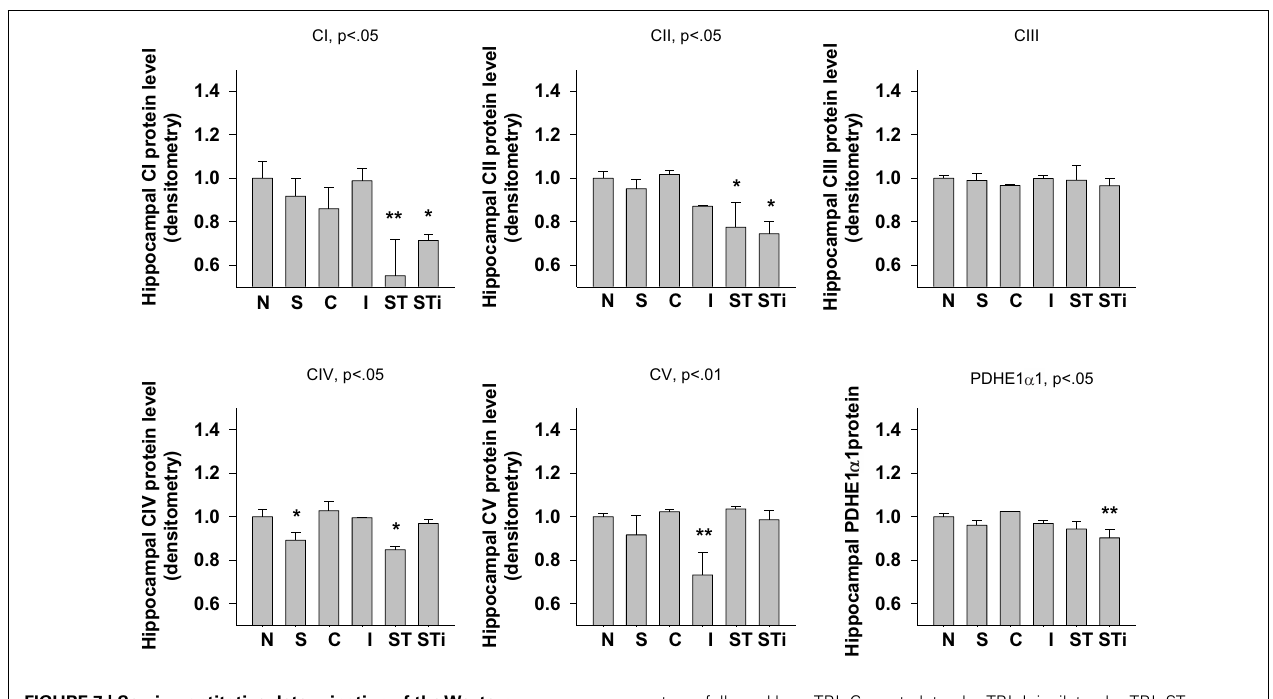
FIGURE 7 | Semi-quantitative determination of theWestern blotting protein bands density of ETC subunits CI, CII, CIII, CIV, CV proteins, and PDHE1 α 1 protein expressed in rat hippocampus 7days post mTBI . N, Naïves; S, 3days repeated stress;T, mTBI; ST,